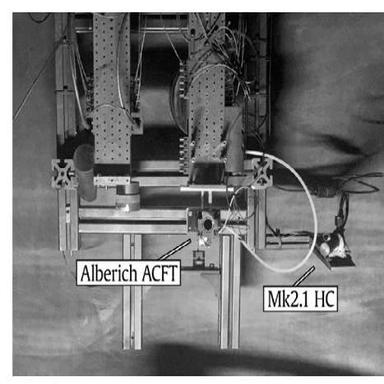
Thrust measurement test setup inside LET's main chamber. The Alberich ACFT is mounted on the thrust balance (left), while the MK 2.1 hollow cathode is on the right.